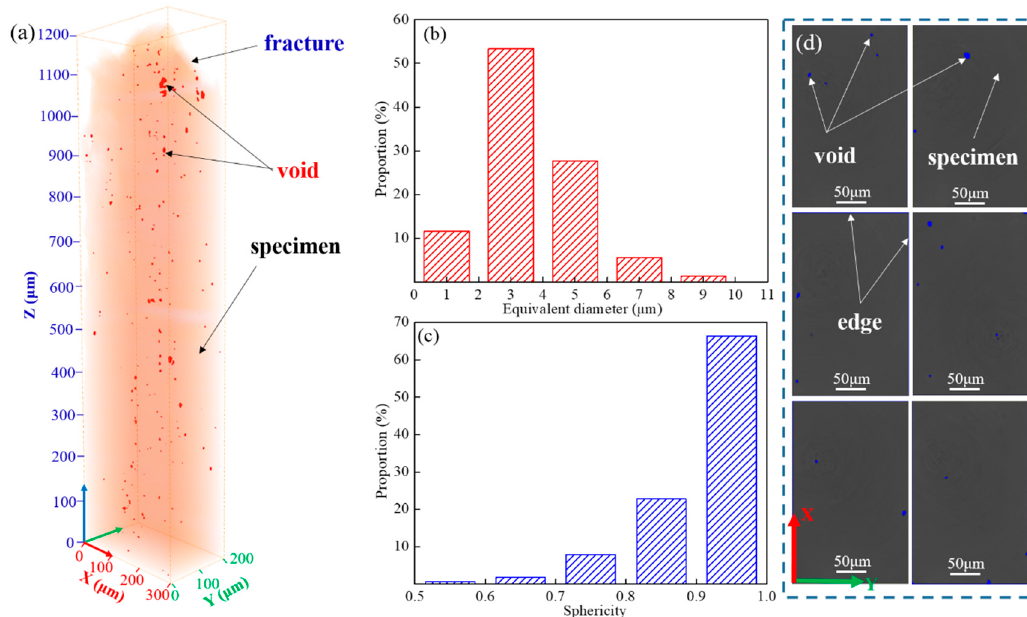
Figure 11. SRXT characterization results for fractured specimen B. ( a ) 3D reconstruction morphology; ( b ) distribution of void equivalent diameters; ( c ) distribution of void sphericity; ( d ) SRXT 2D slices